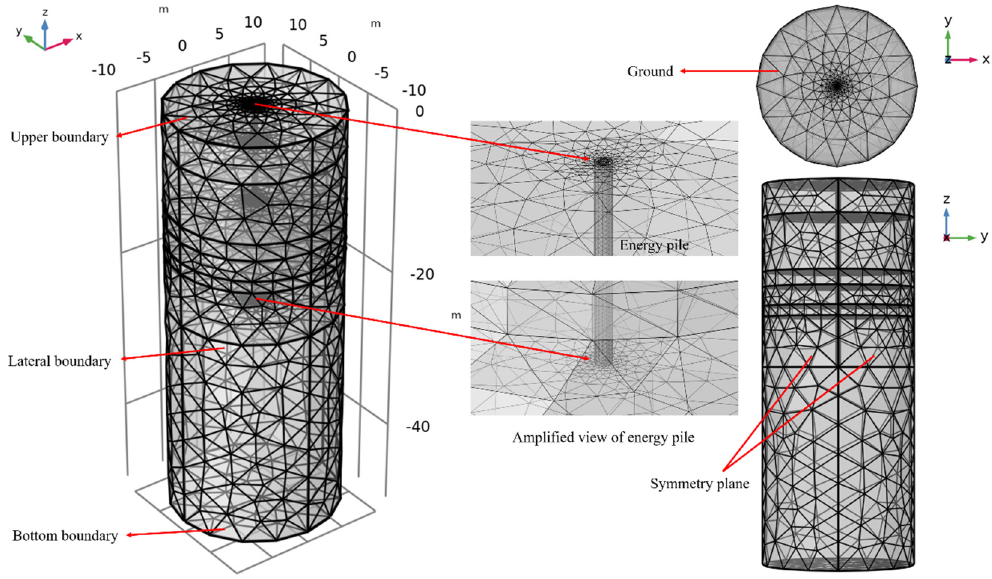
Figure 9. Schematic diagram and mesh of foundation and PHC energy